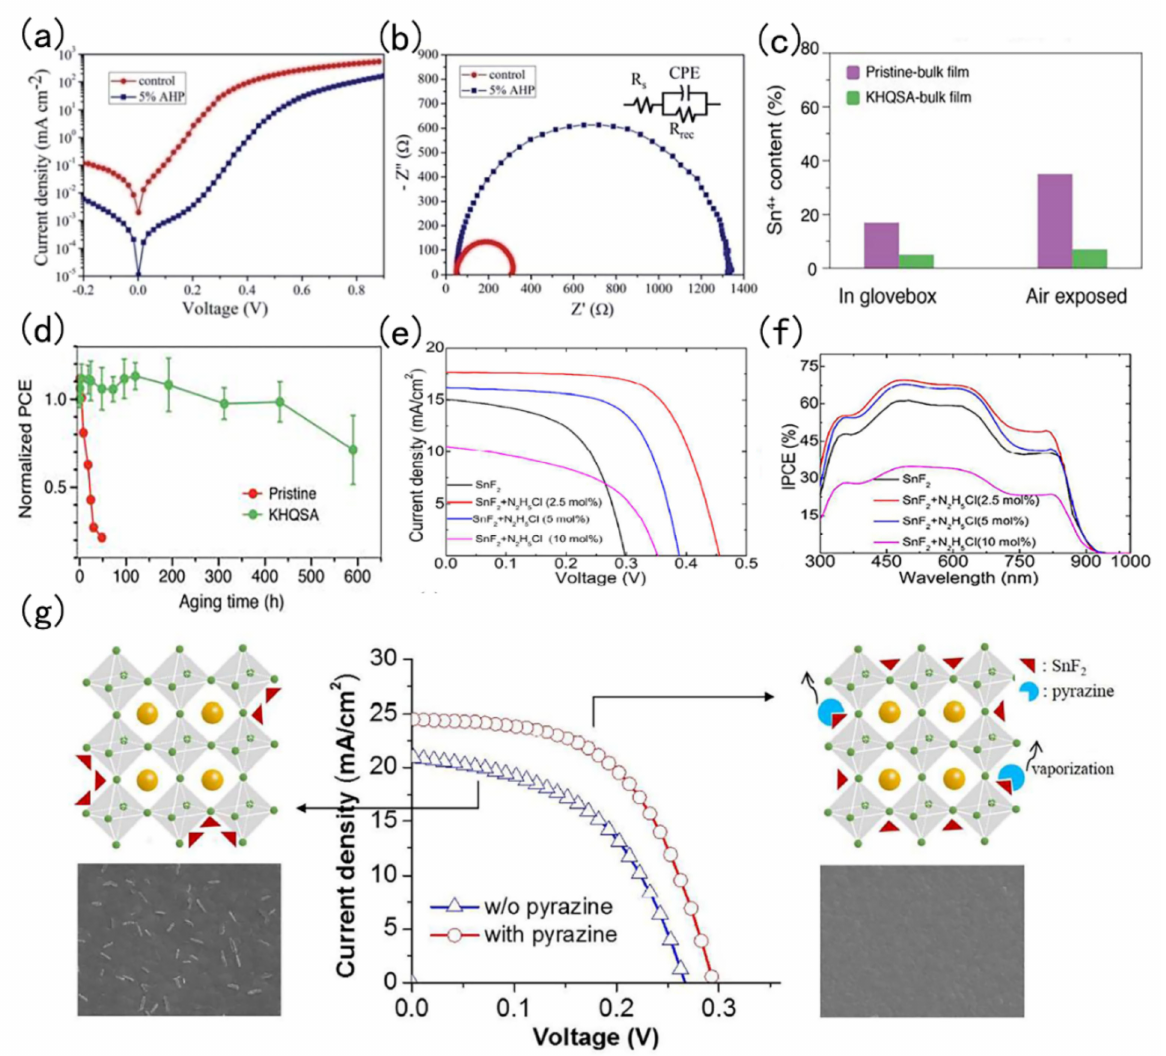
Figure 1. ( a ) J-V curves of FASnI 3 solar cells with and without AHP (measured in the dark). Reproduced with permission from [31]. Copyright 2019 Royal Society of Chemistry. ( b ) Nyquist plots of FASnI 3 solar cells with and without AHP (inset shows the equivalent circuit for fitting. Reproduced with permission from [31]. Copyright 2019 Royal Society of Chemistry. ( c ) The content of Sn 4+ in the original perovskite film and the perovskite film with KHQSA were tested in the glove box and the air environment. Reproduced with permission from [32]. Copyright 2019 John Wiley & Sons—Books. ( d ) Stability of the pristine and KHQSA-modified solar cells upon exposure in the dark air (RH = ~20%) without device encapsulation. Reproduced with permission from [32]. Copyright 2019 John Wiley & Sons—Books. ( e ) A comparison of J-V curves. Reproduced with permission from [33]. Copyright 2018 American Chemical Society. ( f ) A comparison of incident photon-to-electron conversion efficiency (IPCE) change with wavelength. Reproduced with permission from [33]. Copyright 2018 American Chemical Society. ( g ) Comparison of J-V curves of doped pyrazine devices and J-V curves of undoped pyrazine devices and comparison of pyrazine acting on perovskite crystals. Reproduced with permission from [26]. Copyright 2016 American Chemical